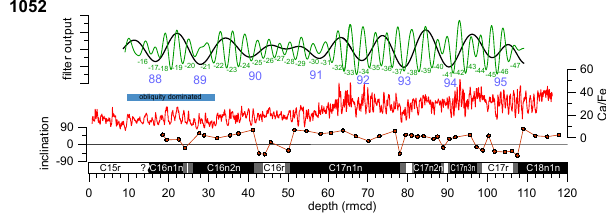
Figure 6. Cyclostratigraphy from Chron C15r to C18n.1n for ODP Site 1052 in the depth domain. Ca / Fe data, revised depth scale and paleomagnetic reversal pattern with errors from Pälike et al. (2001), inclination data from Ogg and Bardot (2001). Numbers represent the assigned short (green) and long (blue) eccentricity cycle maxima positions in the orbital solution (see Supplement Fig. S8). Band pass filters: 405kyr filter in black (0 . 09 ± 0 . 027cm − 1 ); 100kyr filter in green (0 . 32 ± 0 . 096cm − 1 ). Please note the strong obliquity com- ponent present from 10 to 30rmcd in the 1052 sedimentary